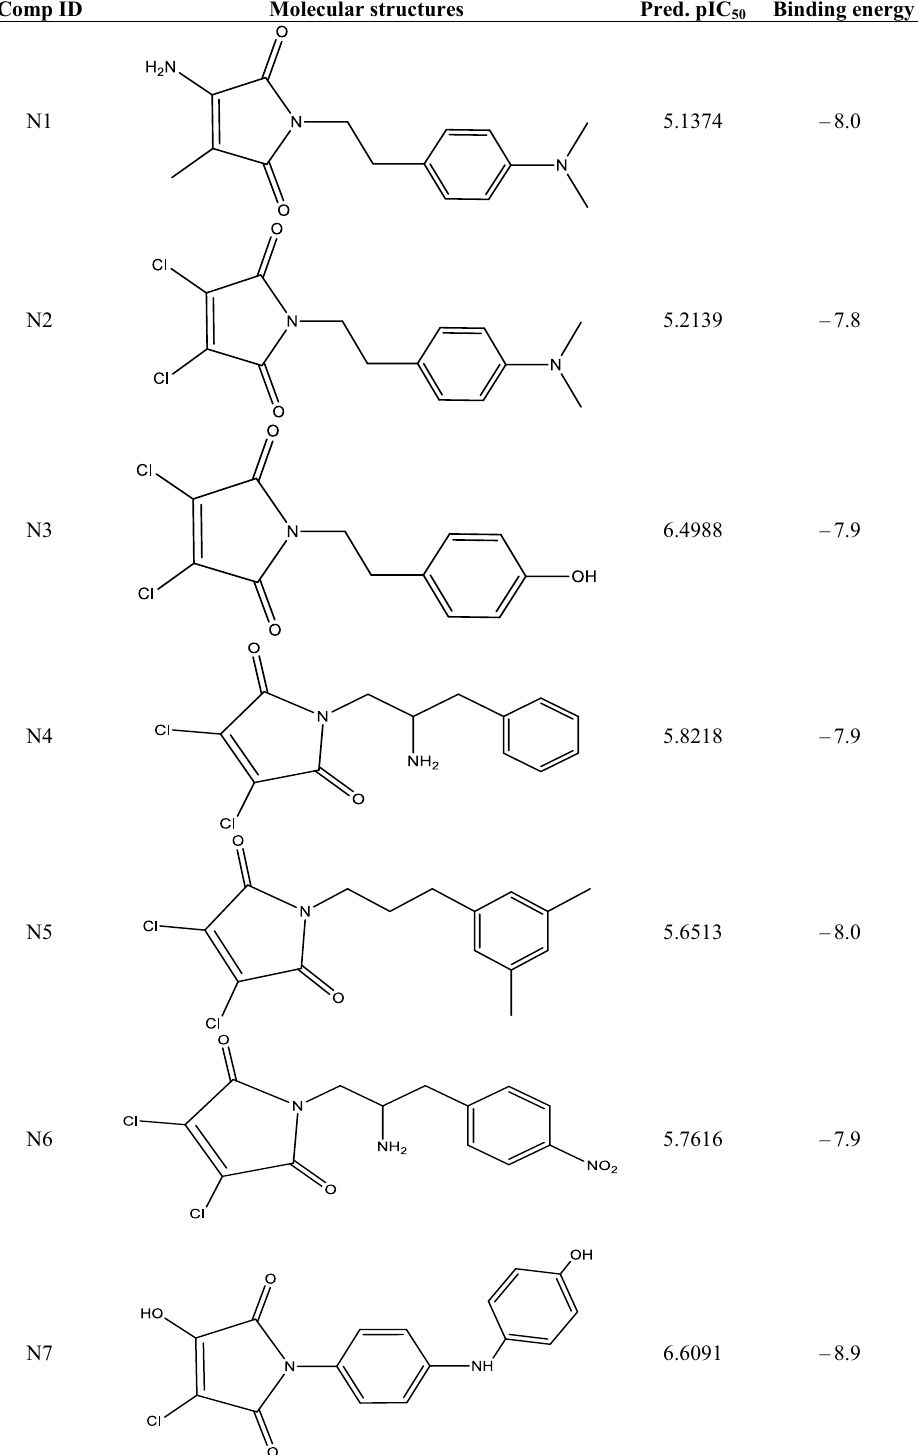
and binding energies of the designed 50